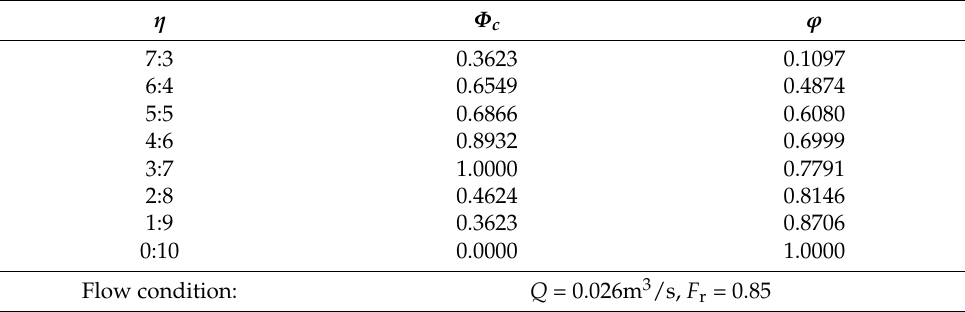
Table 3. The parameters of bed load under various mixture ratios